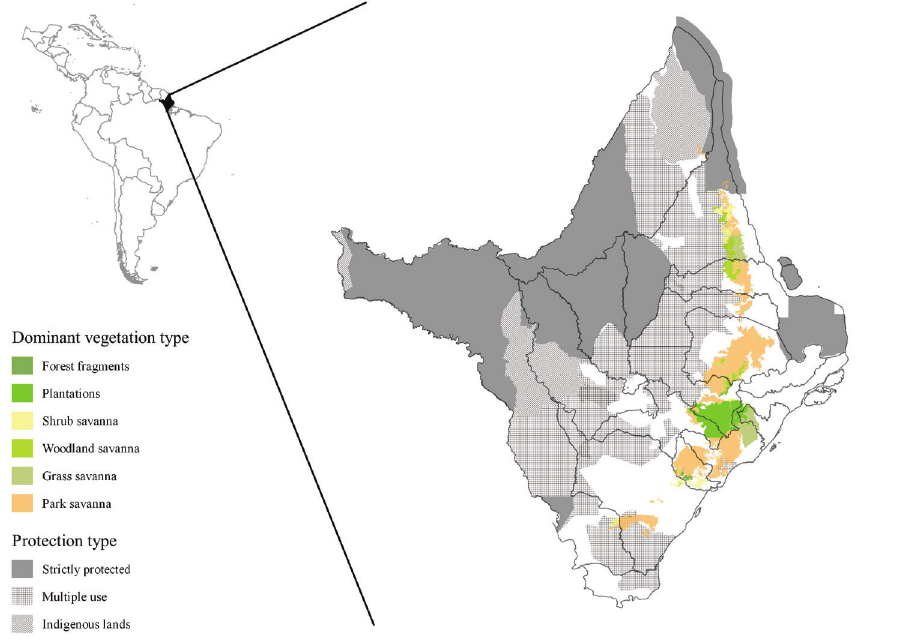
Figure 1. Spatial distribution of dominant savanna types and protected areas in the state of Amapá. Dis- tribution of the four dominant savanna vegetation types (based on the Brazilian Institute of Geography and Statistics (IBGE) vegetation cover map for the Amazon (IBGE 2004a), and the three categories of protected areas (based on the shapefiles of Conservation Units and Indigenous Lands available from the Amapá State Environmental Secretariat (SEMA-AP 2016) and the World Database on Protected Areas (IUCN and UNEP-WCMC 2016) in the state of Amapá. Solid grey lines show the limits of the sixteen municipalities that make up the state. The shapefile of boundaries of the municipalities was also obtained from the Amapá State Environmental